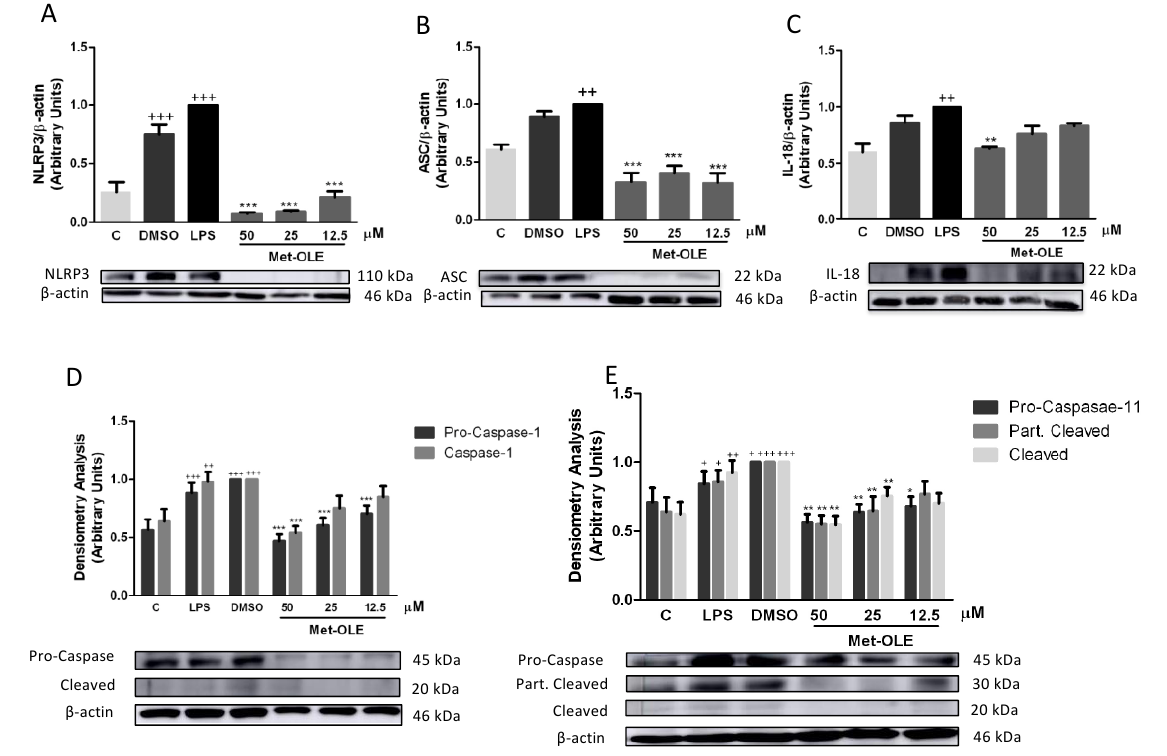
Figure 6. Met-OLE modulated the canonical and noncanonical inflammasome signaling pathways. Cells were pretreated with met-OLE (50, 25 or 12.5 µ M) for 30 min and then, LPS-stimulated during 18 h. ( A ) NLRP3, ( B ) ASC, ( C ) IL-18, ( D ) Pro- and caspase-1 and ( E ) Pro-, partially cleaved and cleaved caspase-11 protein expressions were evaluated by Western blot. Results are presented as the mean ± SEM of at least six independent experiments. + p < 0.05; ++ p < 0.01; +++ p < 0.001 vs. unstimulated cells; * p < 0.05; ** p < 0.01; *** p < 0.001 vs. LPS-DMSO stimulated cells.